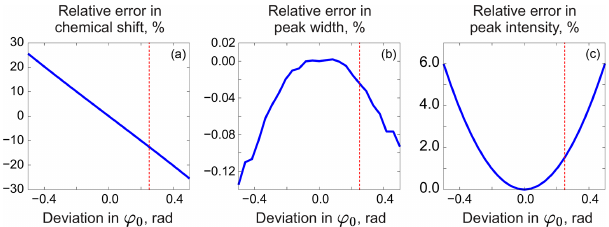
Figure 4. Relative errors in estimated model parameters fitted to an imperfectly phased peak as functions of the phasing error. From left to right: error in the chemical shift (expressed relative to the peak width at half maximum) (a) , error in the peak width (b) , and error in the intensity (c) relative to their respective true values. The red vertical lines indicate the phasing error of 0.25 rad corresponding to the plots in Fig. 3.